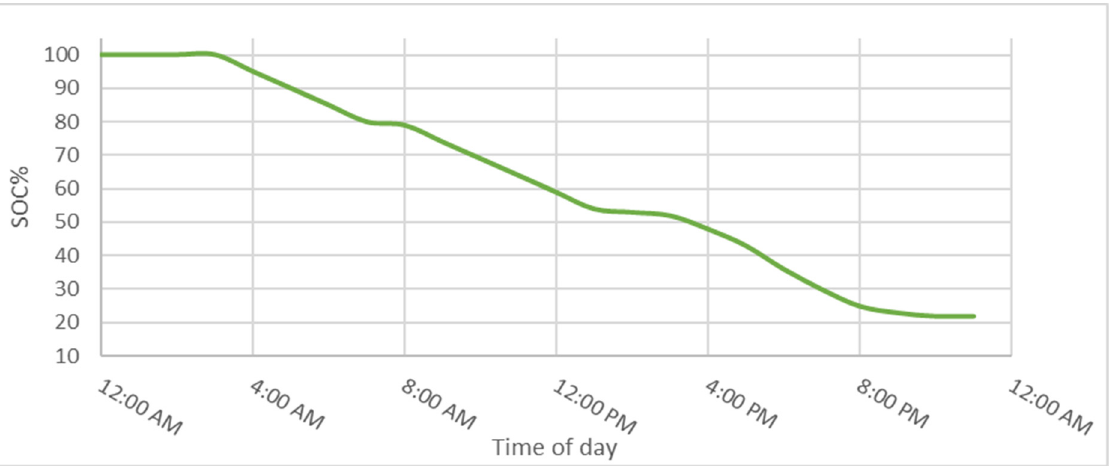
Figure 9. MESS results: battery SOC.